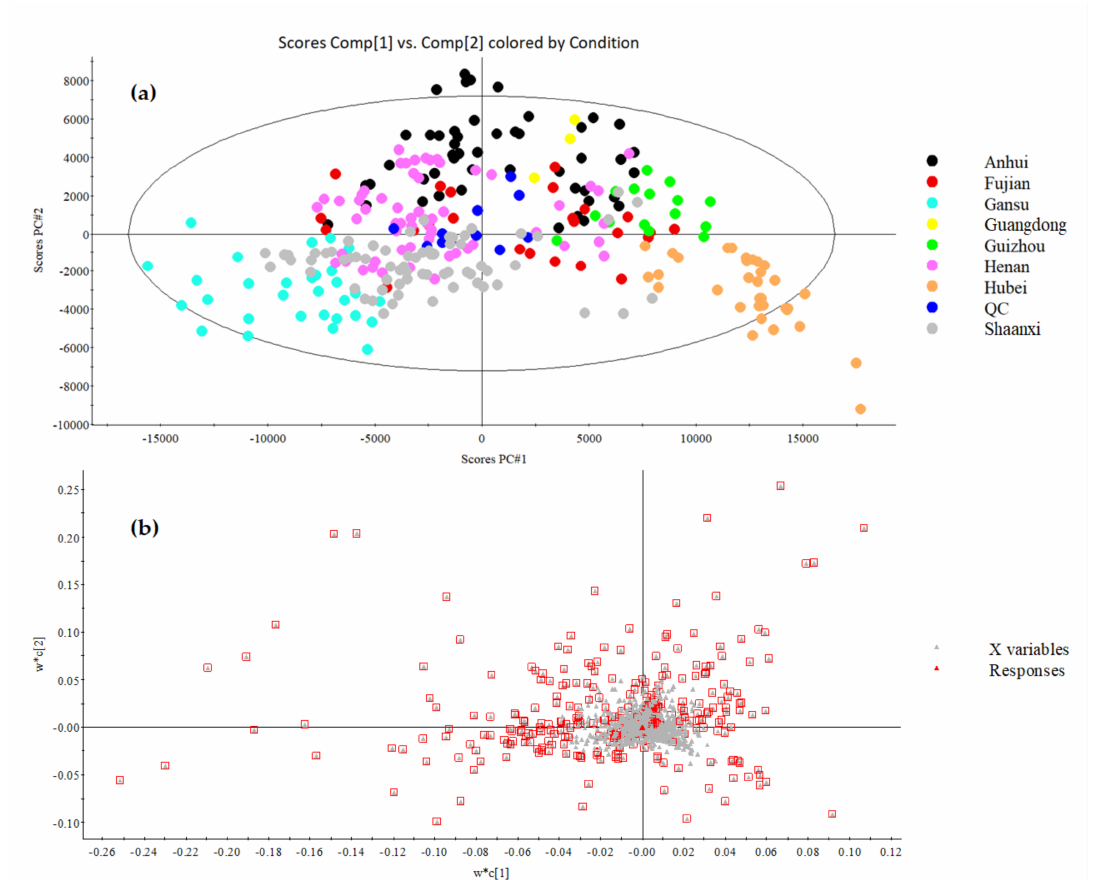
Figure 6. Partial least square discriminant analysis (PLS-DA) ( a ) scores plot and ( b ) loading plot of wheat samples from eight provinces in China. * X variables with the red box in the loading plot were the markers with VIP values >